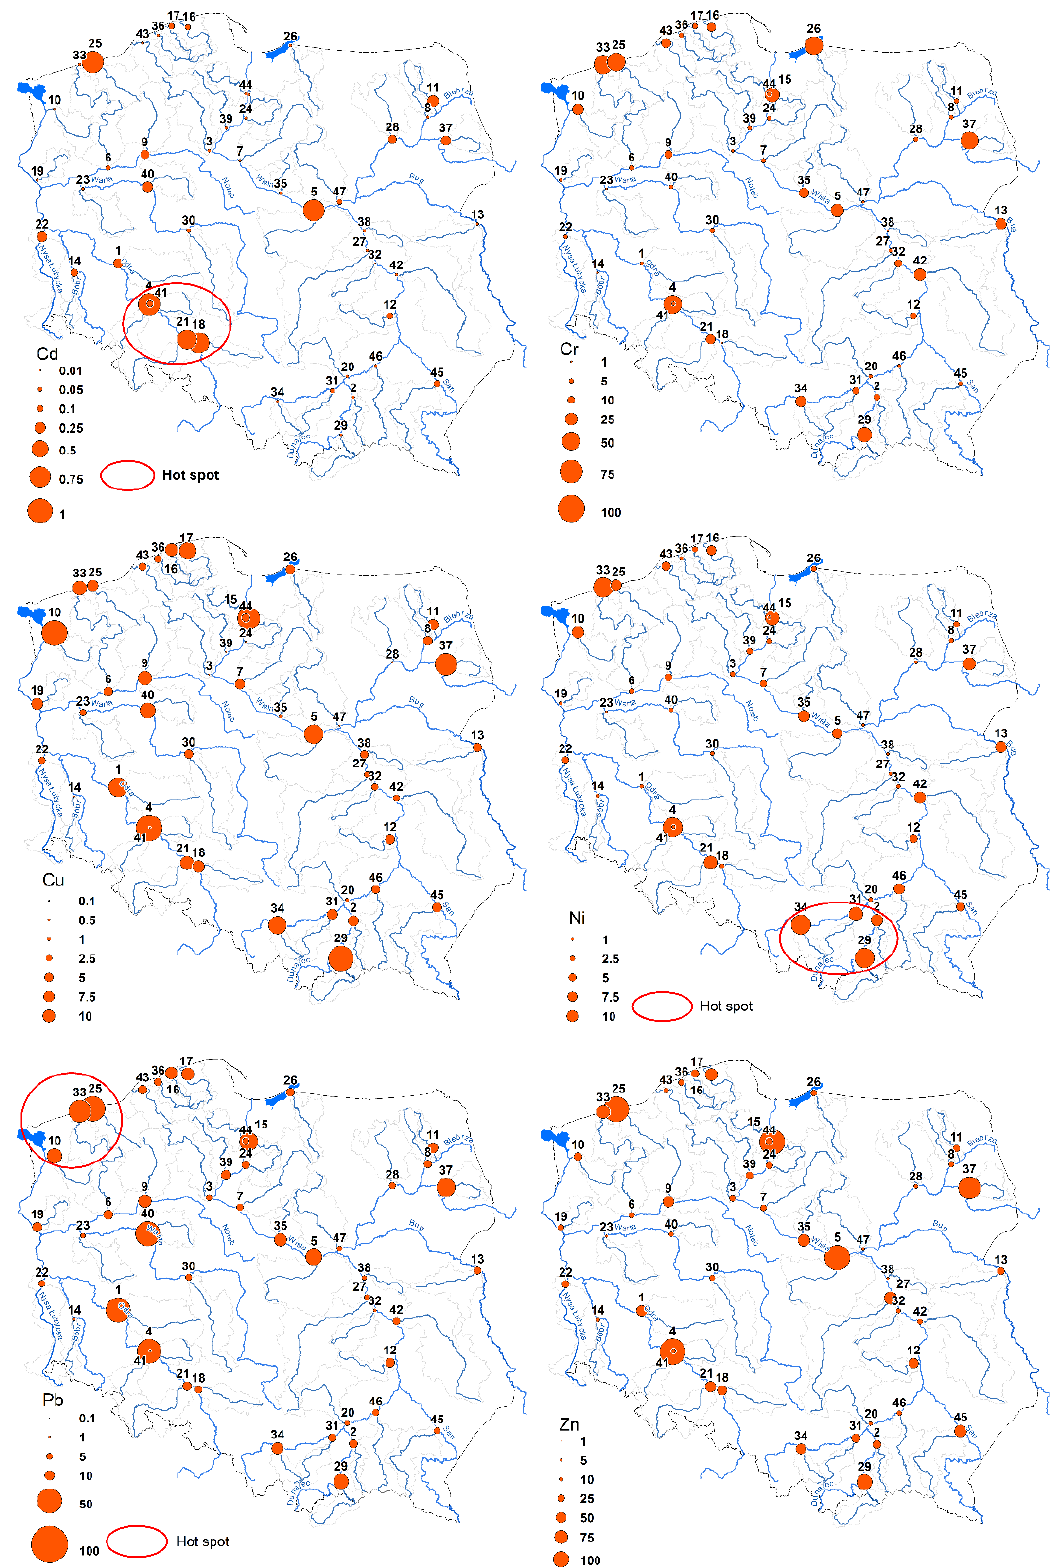
Figure 8. Hotspot locations of Cd, Ni and Pb concentrations based on the Getis-Ord 𝐺 𝑖∗ statistic. The numbers of sampling points are listed in the Appendix A.